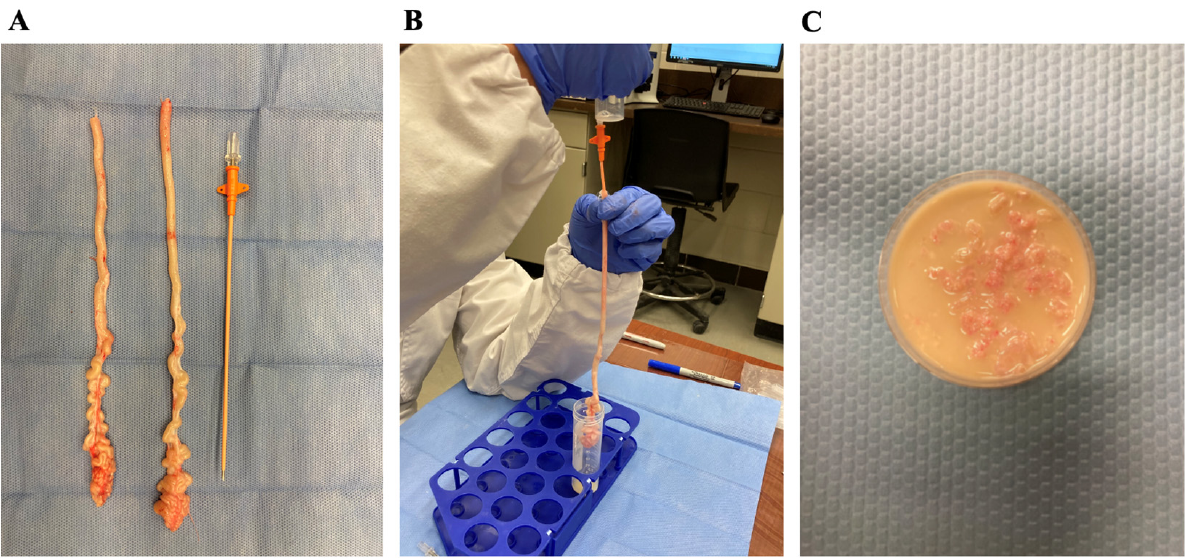
Figure 1. Epididymal sperm harvesting from a horse. The tail of the epididymis was dissected from the testis ( A ); the distal portion was straightened out, and an intravenous catheter was placed inside the lumen ( B ). Once the retrograde flushing of the tail was completed, the tail was minced into 1–2 mm pieces and submerged in an egg-yolk-based extender for 15–20 min ( C ).